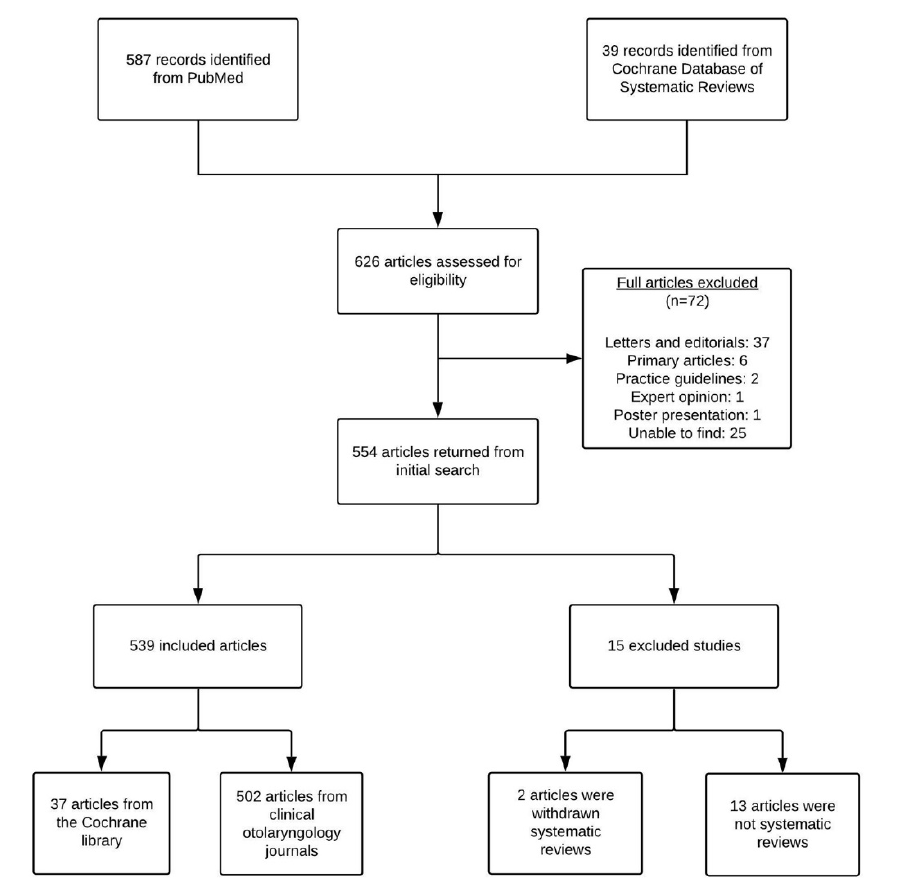
Figure 1 Flow diagram of included and excluded